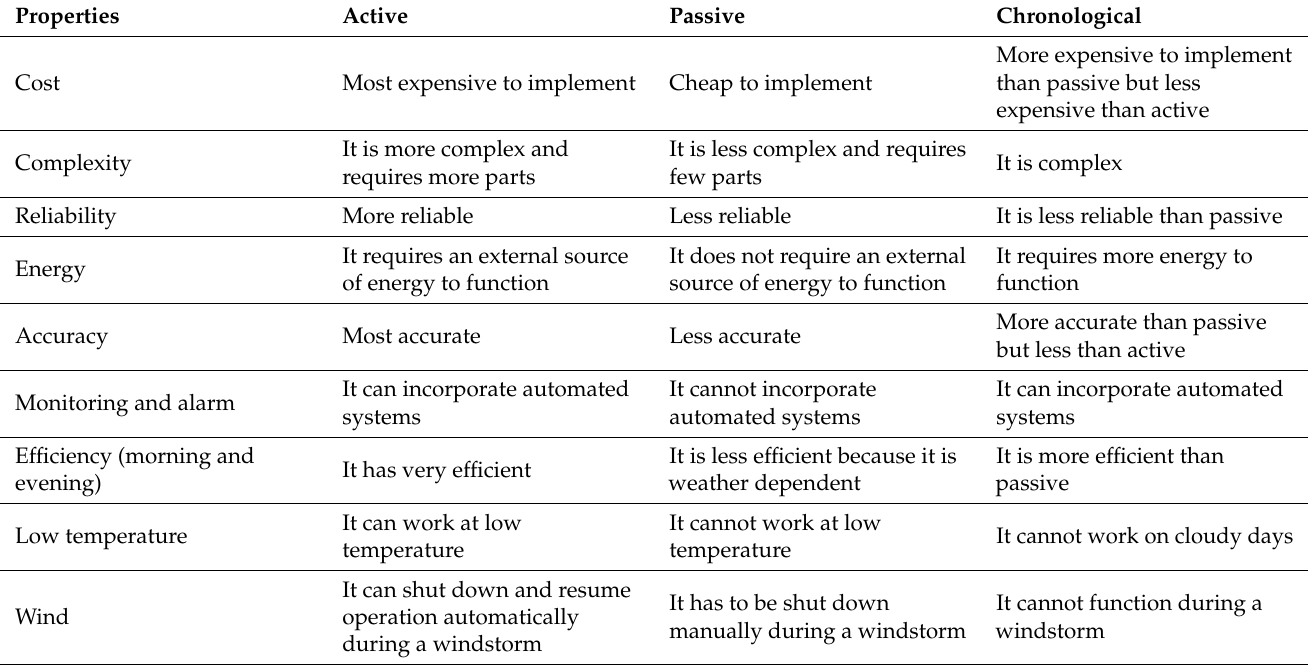
Table 2. Comparison between the Solar Tracking System based on Drive